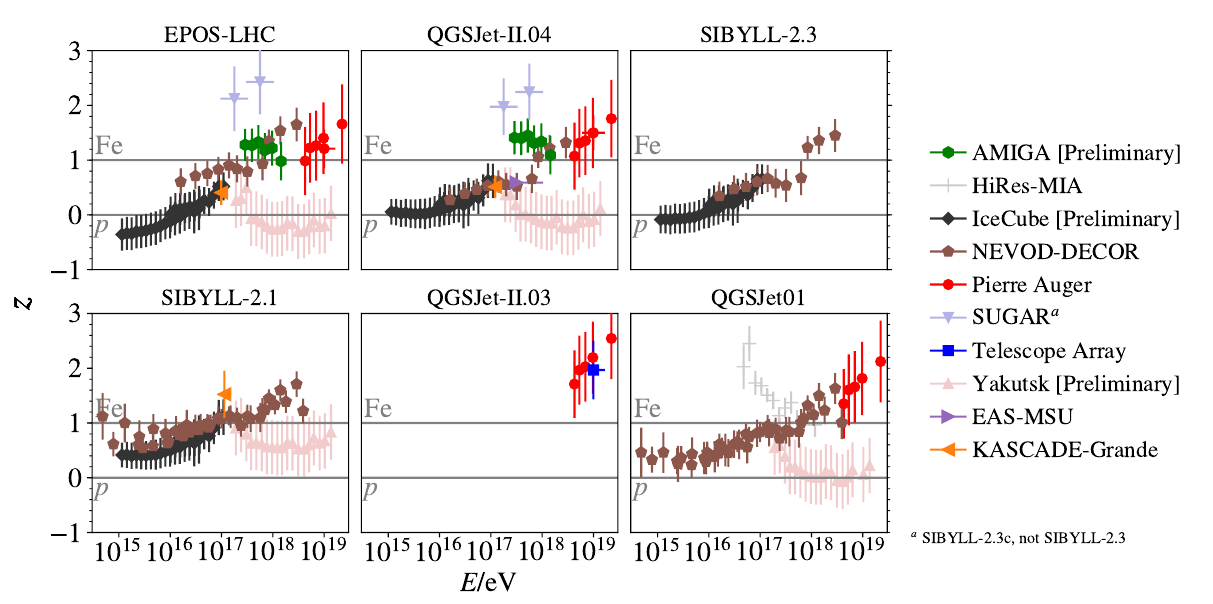
Figure 6. Muon density measurements converted to the z -scale, as described in the text. It depends on the hadronic interaction model, so the same data sets are repeatedly shown for di ff erent models. When corresponding simulations are missing for an experiment, no points can be shown. Error bars show statistical and systematic uncertainties added in quadrature (systematic uncertainties are dominant for nearly all measurements).